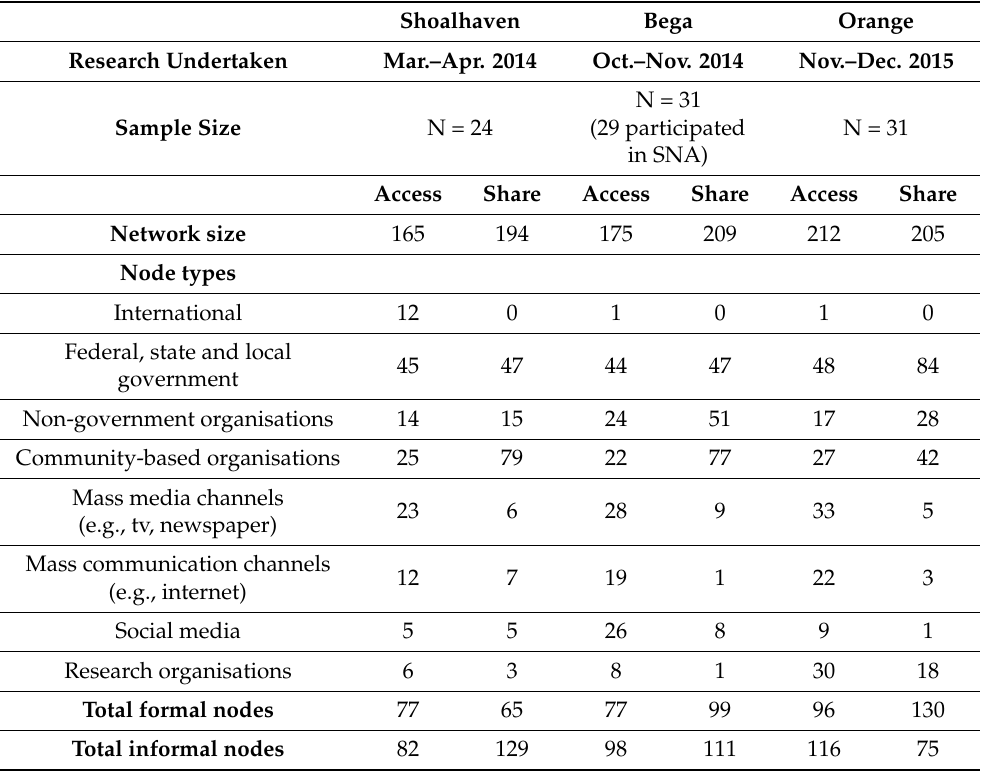
Table 4. Case study and node